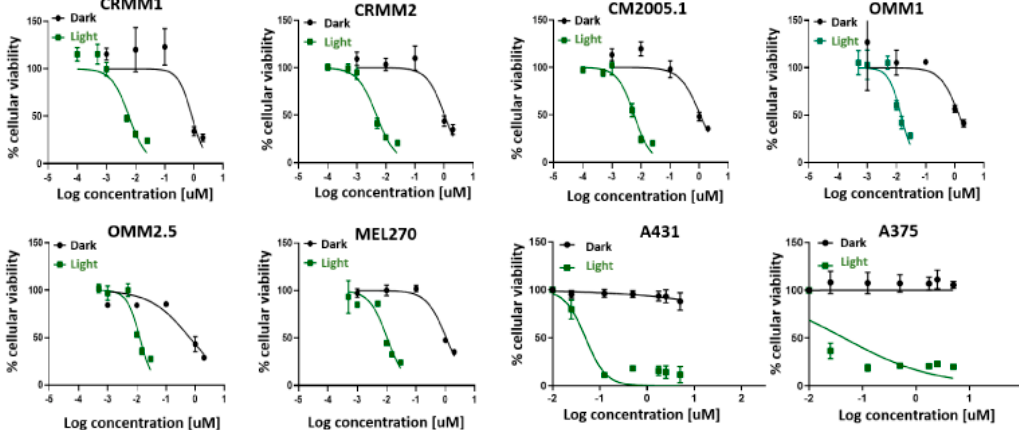
Figure 2. Cell viability after TLD1433 treatment of eight tumour cell lines (CRMM1, CRMM2, CM2005.1, OMM1, OMM2.5, MEL270, A431, A375). The green line shows TLD1433 activated by 520 nm